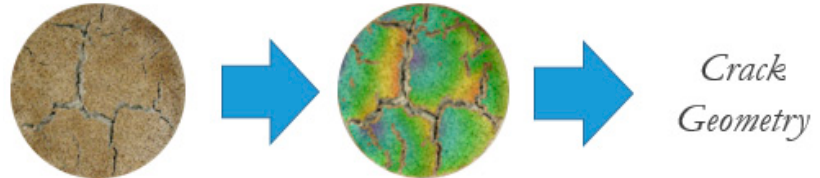
Figure 3. Image processing using GOM Correlate.